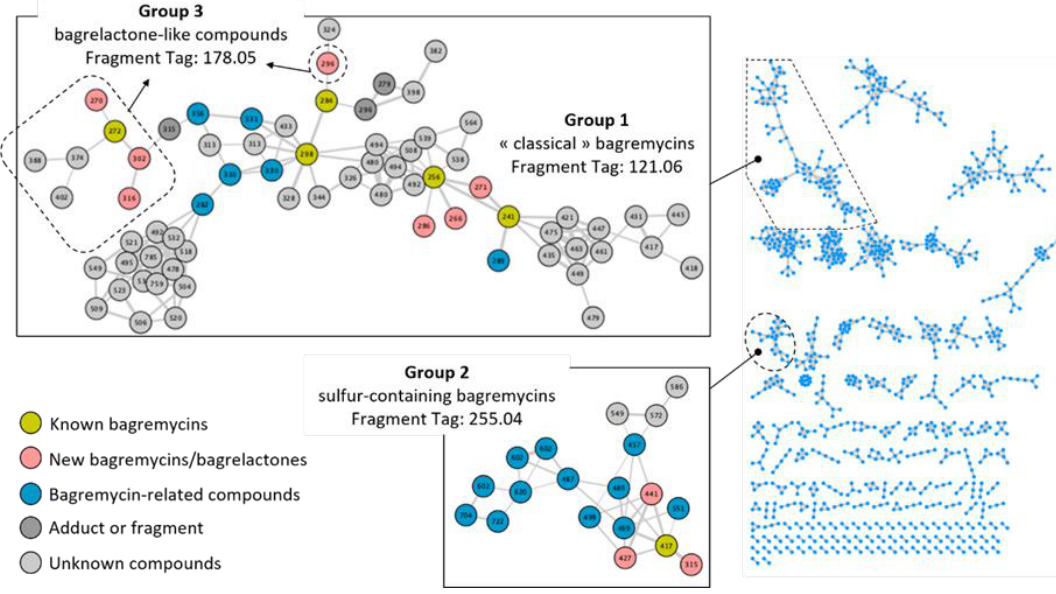
Figure 6. Molecular network of compounds produced by S. lunaelactis strains MM25, 31, 37, 40, 83, 109 T , 113 grown on the ISP7 media. Constellations of nodes were generated using the Global Natural Product Social Molecular Networking (GNPS) software processing the Ultra-Performance Liquid Chromatography–Tandem Mass Spectrometry (UPLC–MS/MS) data obtained for the full extracts of each strain. Each node represents a parent mass (MS1) of a compound detected in the full extract. Compounds are linked by a straight line when they share similar fragmentation patterns. The color code reflects the current knowledge on the structure of a compound: green, previously known bagremycins; pink, new bagremycins identified in this study for which we could propose a structure based on UPLC–MS/MS data; blue, compounds for which we could predict a molecular formula; grey, unknown compounds.